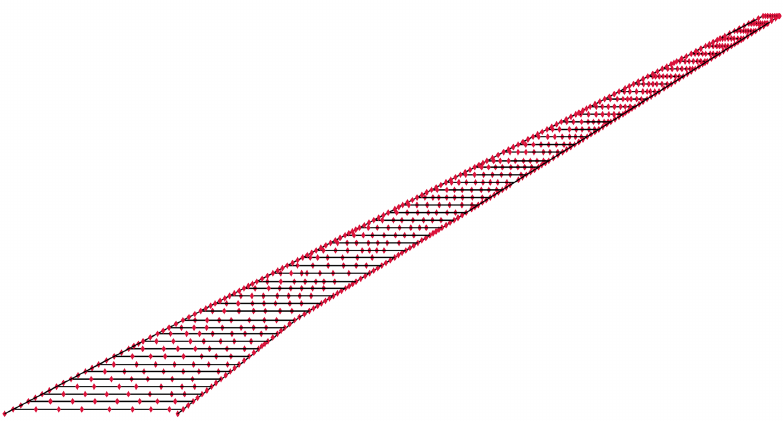
Figure 3. FEM structural nodes used for aerodynamic-loads interpolation